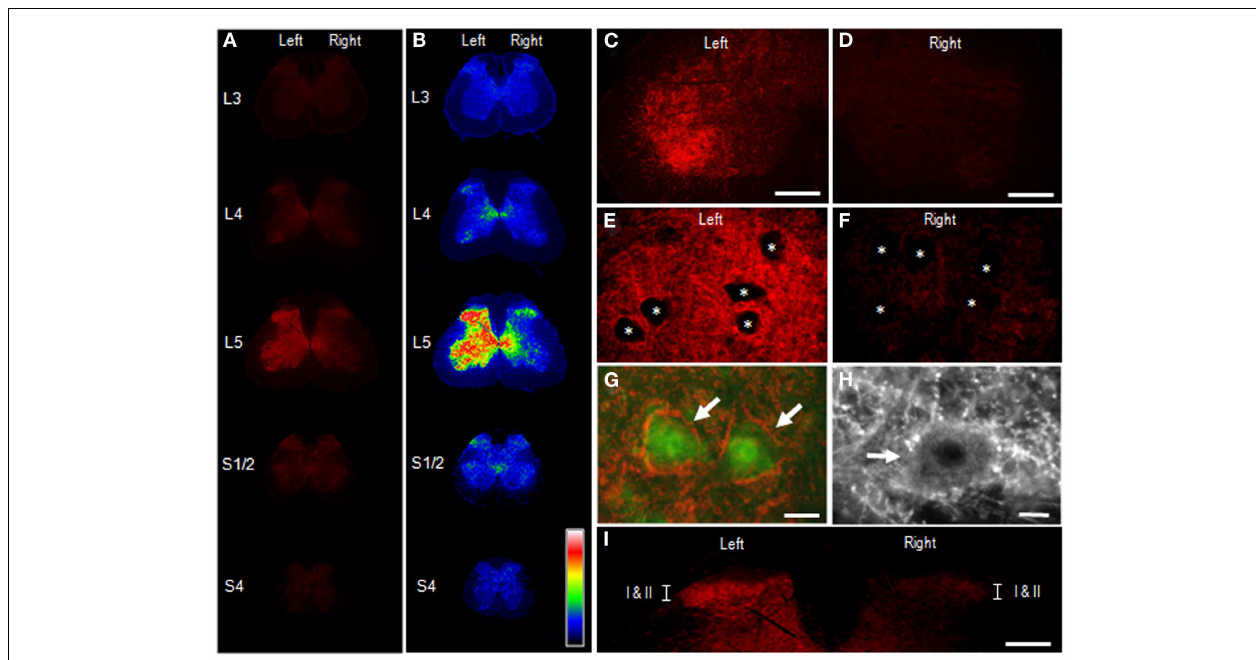
bars = 200 µ m. (E,F) Photomicrographs of the ventral horns (lamina IX) stained for ipsilateral (E) and contralateral (F) to peripheral toxin injection. Asterisks indicate spinal motoneurons. Scale bars = 50 µ m. (G) Photomicrograph of spinal motoneurons (arrows) doubly stained for ChAT (green) and cSNAP-25 (red) ipsilateral to peripheral toxin injection. Scale bar = 25 µ m. (H) High power-magnified photomicrograph with a longer exposure time showing a motoneuron (arrow) that exhibits cSNAP-25-immunoreactive puncta in its soma. Scale bar = 10 µ m. (I) Photomicrograph of the dorsal horns labeled for cSNAP-25, which contain lamina I and II (I/II). Scale bar = 400 µ m.